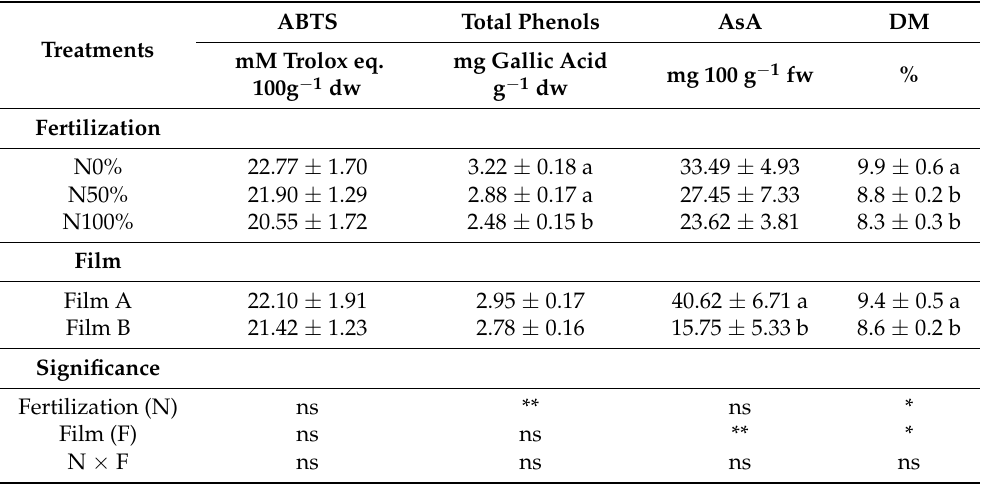
Table 2. Effect of N fertilization (not fertilized = N0%; fertilized with 25 kg N ha − 1 = N50%; fertilized with 50 kg N ha − 1 = N100%) and plastic film (clear plastic film = Film A; light diffusion plastic